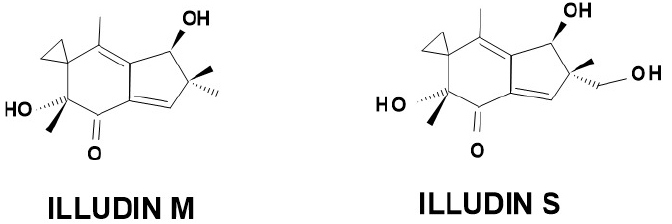
Figure 3. Chemical structure of the similar illudin M and illudin S compounds.